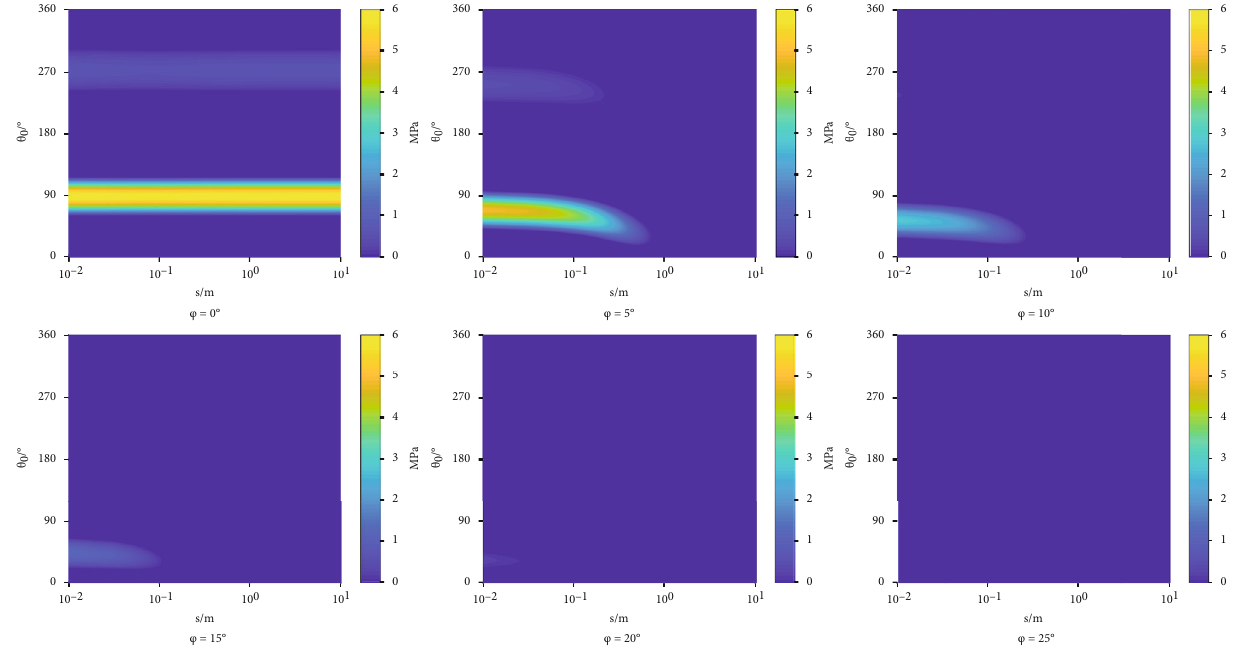
Figure 5: Maximum tensile stress increasing region with di ff erent intersection